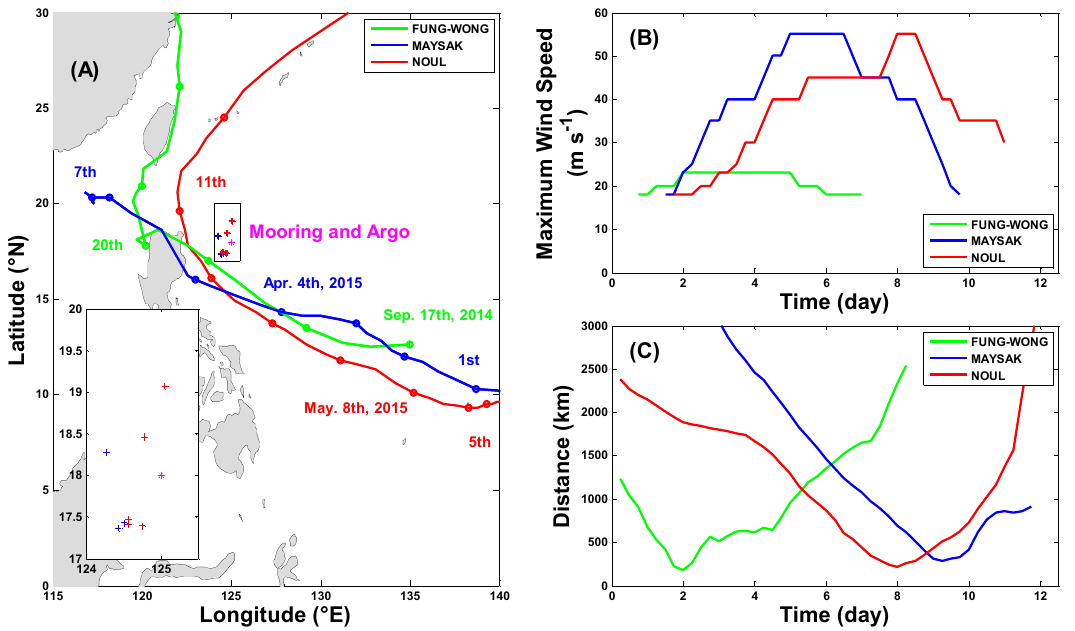
Figure 1. ( A ) Best tracks of typhoon Fung-Wong (No. 16) in 2014, typhoon Maysak (No. 4) in 2015, and typhoon Noul (No. 6) in 2015. The magenta asterisk indicates the location of the mooring, and the plus signs are the locations of the Argo buoys. The horizontal axis of ( A ) is longitude with the unit ◦ E. The vertical axis is latitude with the unit ◦ N. Locations of the Argo profiles were labeled with the different colors corresponding to different typhoon passages. ( B ) Maximum wind speed over time from when each typhoon was generated. The horizontal axis of ( B ) is time with the unit day. The vertical axis is maximum wind speed with the unit ms − 1 . ( C ) Distance between each typhoon and the mooring over time from when each typhoon was generated. The horizontal axis of ( C ) is time with the unit day. The vertical axis is distance with the unit km. All these three figures in Figure 1 have the same legend.